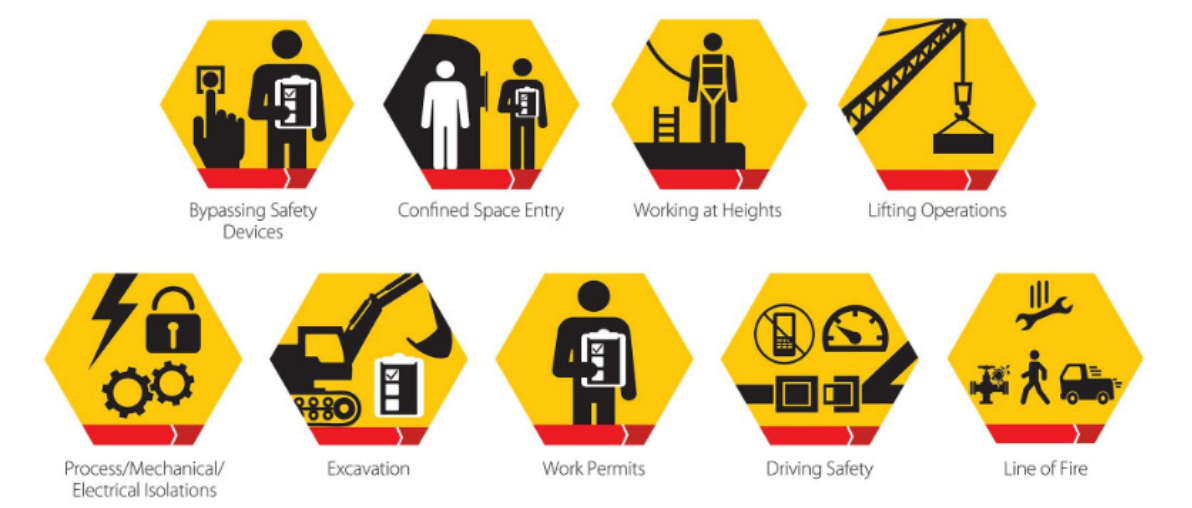
Figure 18. Typical safety signs that are used on offshore platforms for the oil and gas industry.